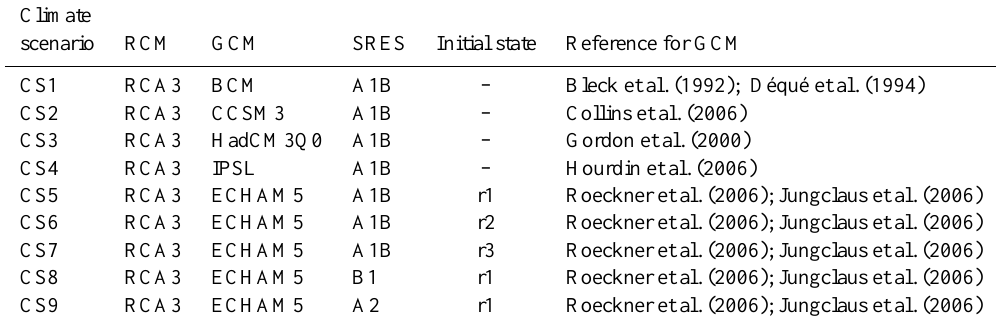
Table 2. Summary of the different climate model projections used in this study (see also Kjellström et al., 2011). RCM stands for regional climate model, GCM for global climate model, and SRES stands for the greenhouse gas emission scenarios as defined in the special report on emission